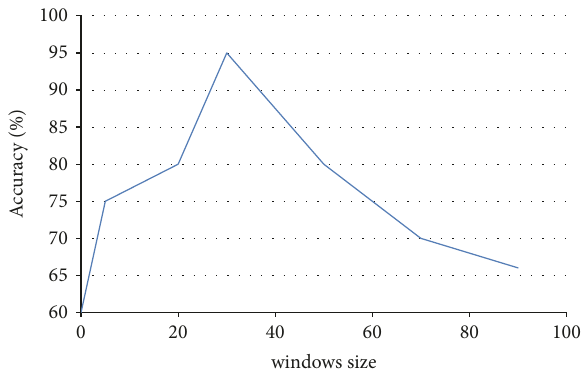
Figure 6: Performance evaluation with different window sizes.